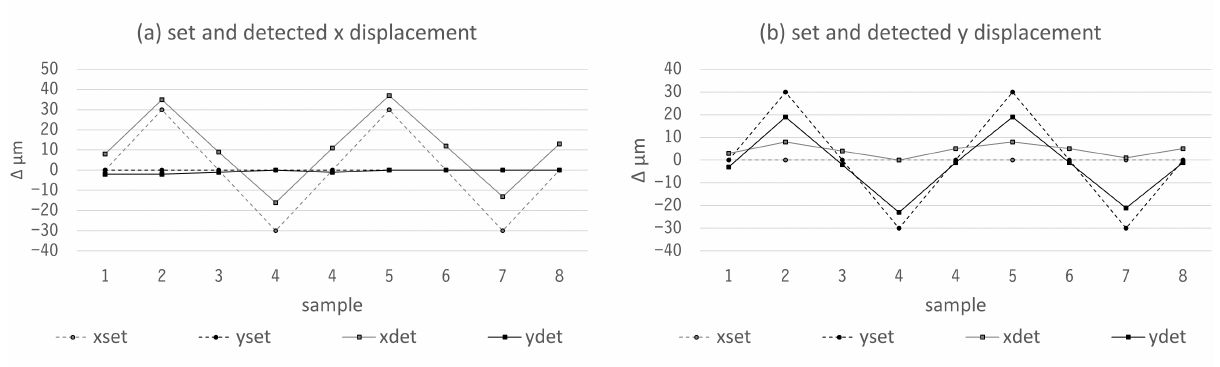
Figure 11. Positioning accuracy measurements for x and y axes. First, a displacement was induced by the controller (x set, y set), which then was measured by the laser interferometer (x det, y det). ( a ) Movement in x direction. The measurement shows a 10 µm offset and a small drift. ( b ) Movement in y direction. The measurement shows only a very small offset and no drift but a parasitic movement in the x